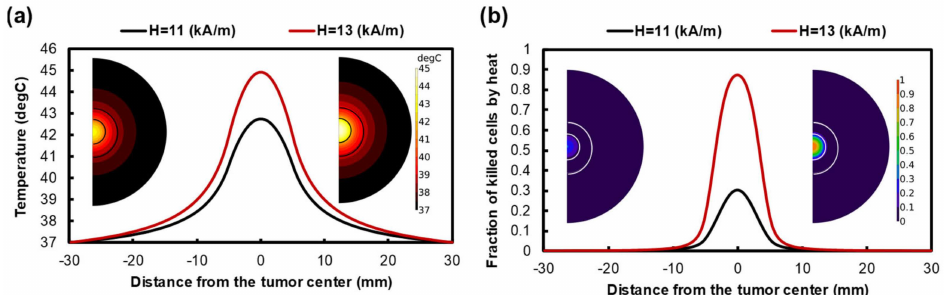
Figure 4. ( a ) Temperature profile after 60 min of heating with a frequency of 400 kHz and a magnitude magnetic field of 11 kA/m and 13 kA/m. Despite increasing the temperature level by using higher intensity, the temperature profile is limited to the injection site. ( b ) The fraction of killed cells after 60 min